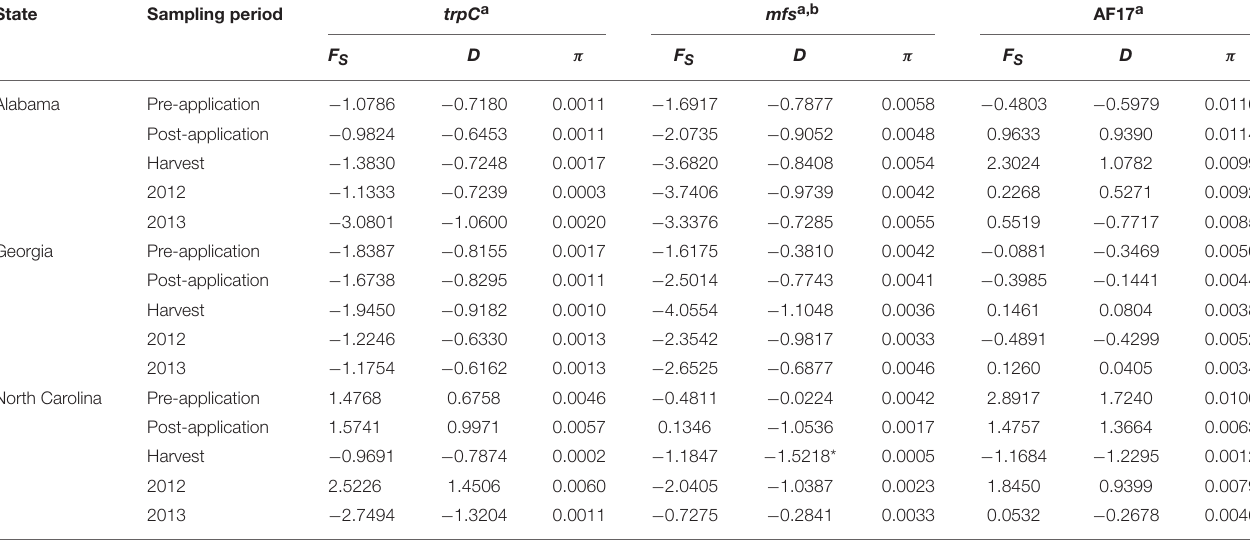
TABLE 7 | Neutrality based on Fu ( F S ) and Tajima ( D ) tests and nucleotide diversity estimates ( π ) for the three multilocus sequence typing loci for populations of Aspergillus flavus collected from fields in the southeastern United States treated with Afla-Guard and AF36 biocontrol strains. State